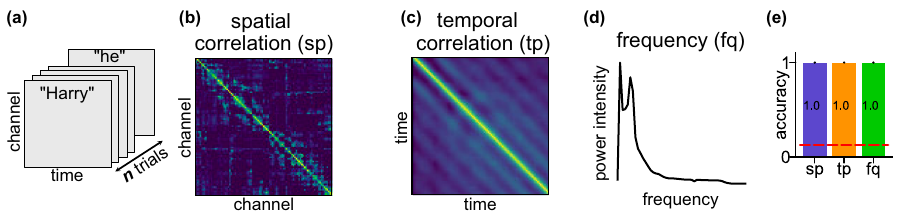
Fig. 3 High within-session identi fi cation accuracy on HP data with three interpretable features. a Shape of the HP data before featurization. The HP data consists of participants reading a book chapter one word at a time for 0.5s each. The data are resampled to have the dimension [102 channels, 100 time points, n trials] where each trial corresponds to one word and n to the number of words. b The spatial correlation feature sp is a 102 × 102 Pearson's correlation coef fi cient matrix computed across the time points and trials. c The temporal correlation feature tp is a 100 × 100 Pearson's correlation matrix computed across the channels and trials. d The frequency feature fq is a vector in R 51 where 51 is the number of frequency bands. The power at each band was averaged across channels and trials. e Identi fi cation accuracy with the three features. The accuracy was averaged across 100 identi fi cation runs of 8 individuals. The red dashed line represents the chance level ( = 0.125). The error bars are the standard errors across individuals and identi fi cation runs and are invisible since they are all